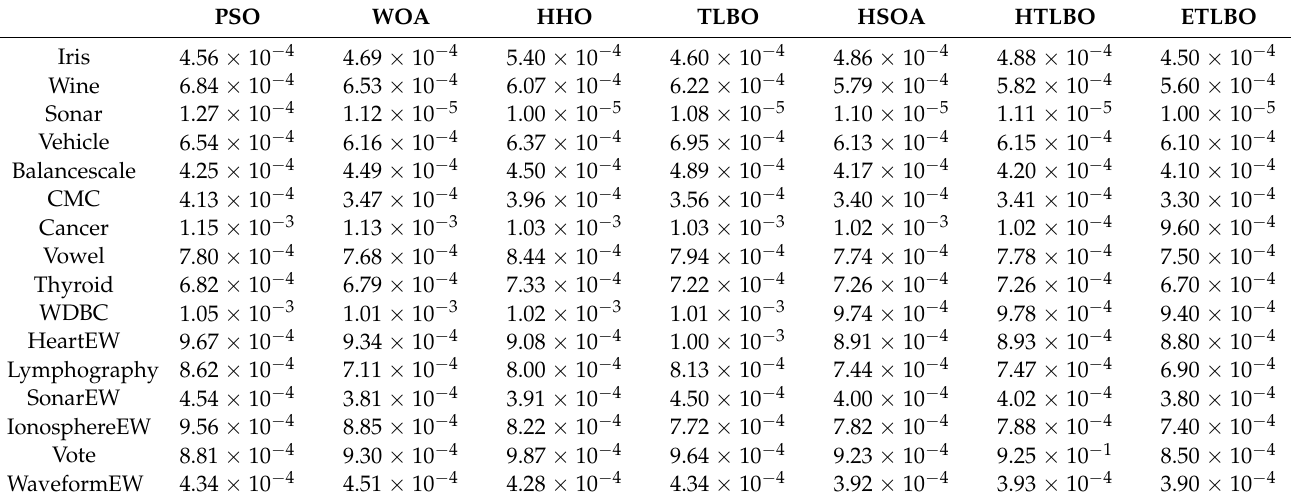
Table 3. The std of fitness